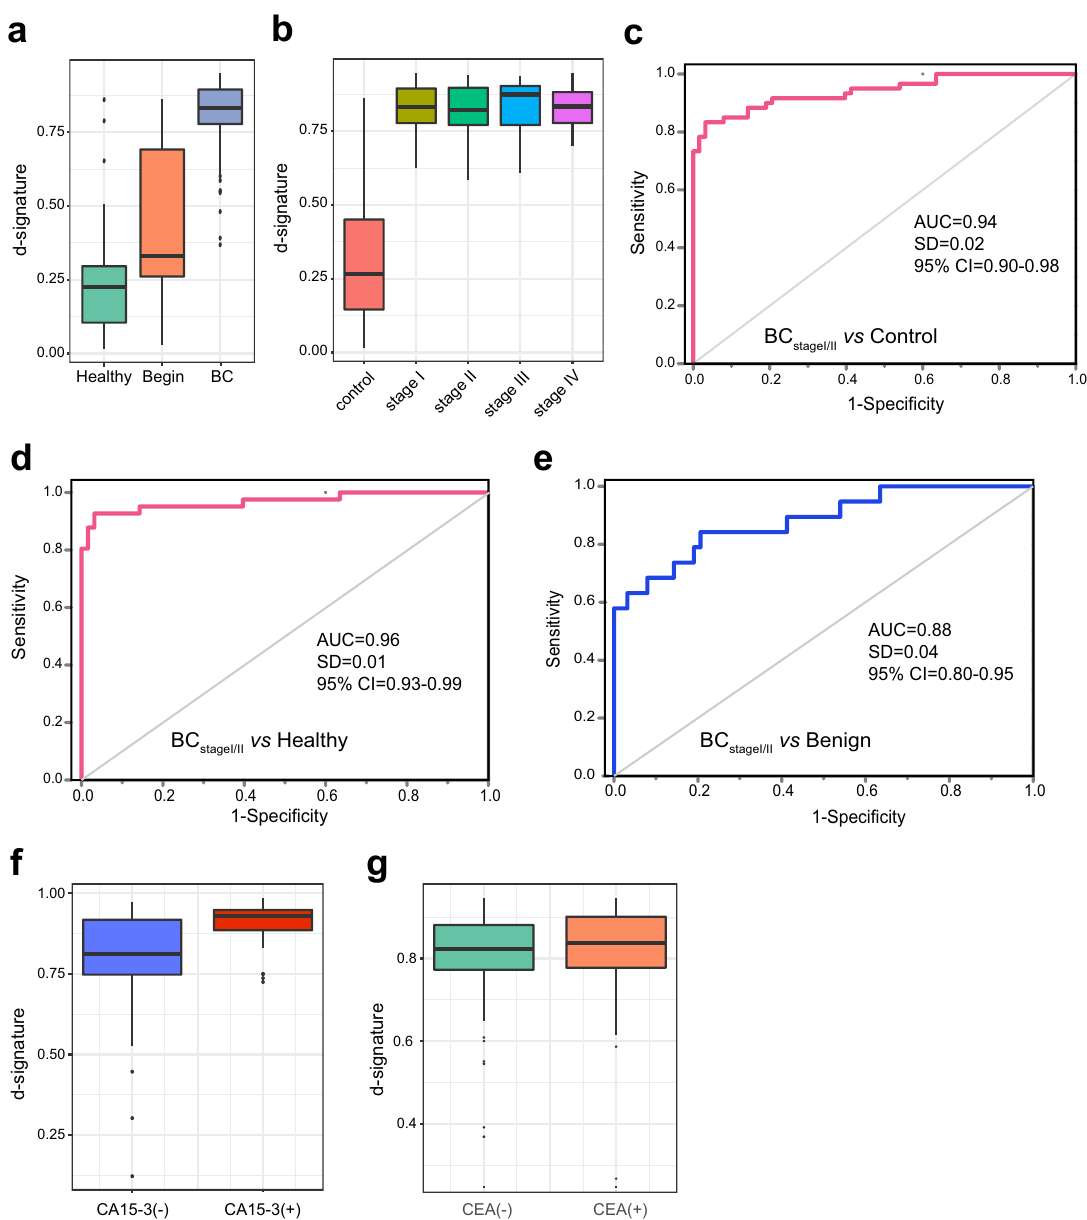
Fig. 4 ExLR-based d-signature for the diagnosis of early stage BC. a ExLR d-signature scores in healthy ( n = 41), benign ( n = 19), and BC ( n = 112). b ExLR d-signature scores in BC patients with stage I ( n = 28), II ( n = 35), III ( n = 15), and IV ( n = 34). c – e ROC for the performance of the exLR d-signature in BC with early stages (Stage I/II) compared to control ( c ), healthy ( d ), and benign ( e ). f , g ExLR d-signature scores in BC patients with different serum CA15-3 ( f ) and CEA ( g ) statuses. AUC area under the curve, SD standard deviation, CI con fi dence